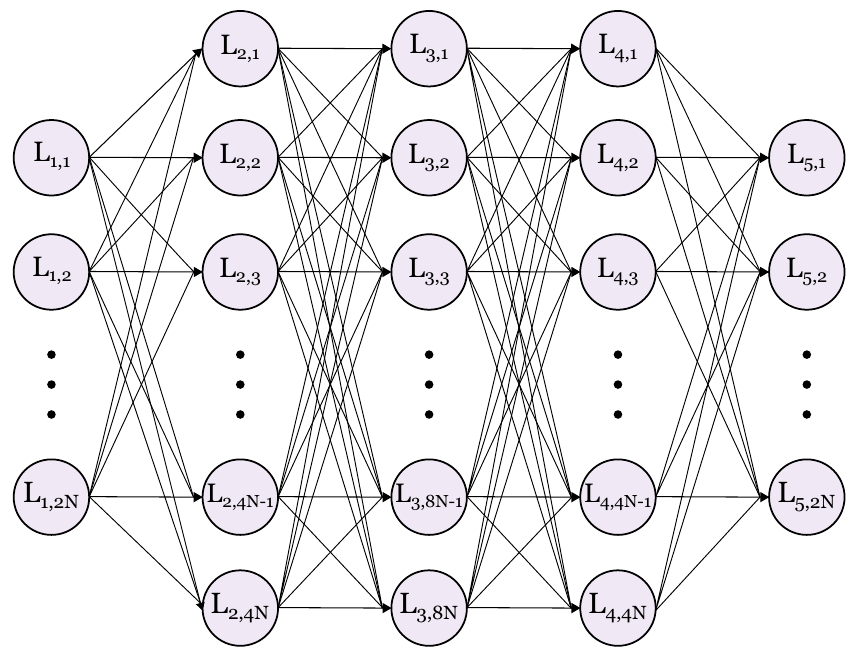
Figure 2. Block diagram of the neural